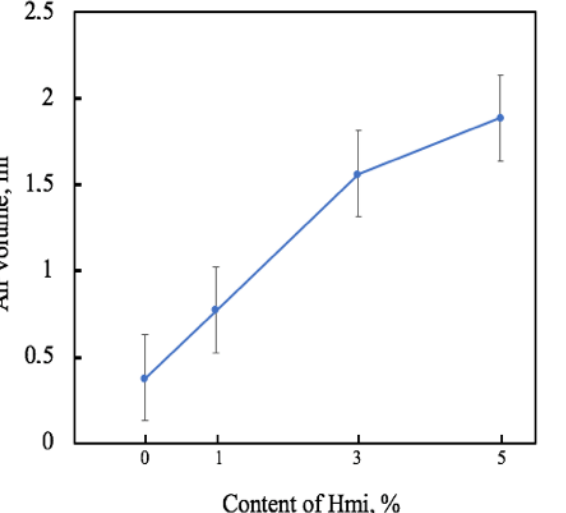
Figure 6. Air volume that passed through the fibrous materials based on PHB–Hmi according to the Gurley method.